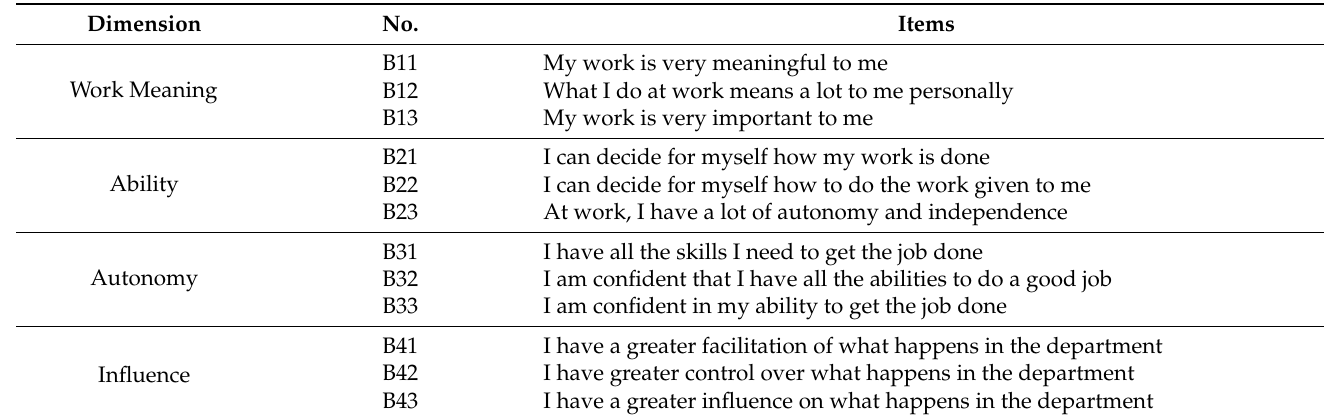
Table 2. Psychological Empowerment Measurement